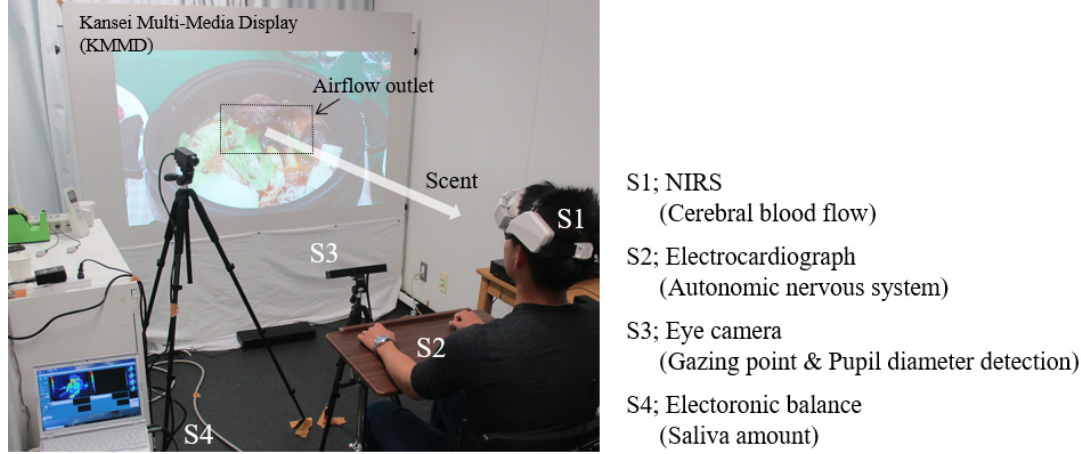
Figure 2. Experimental environment with KMMD and measuring devices.